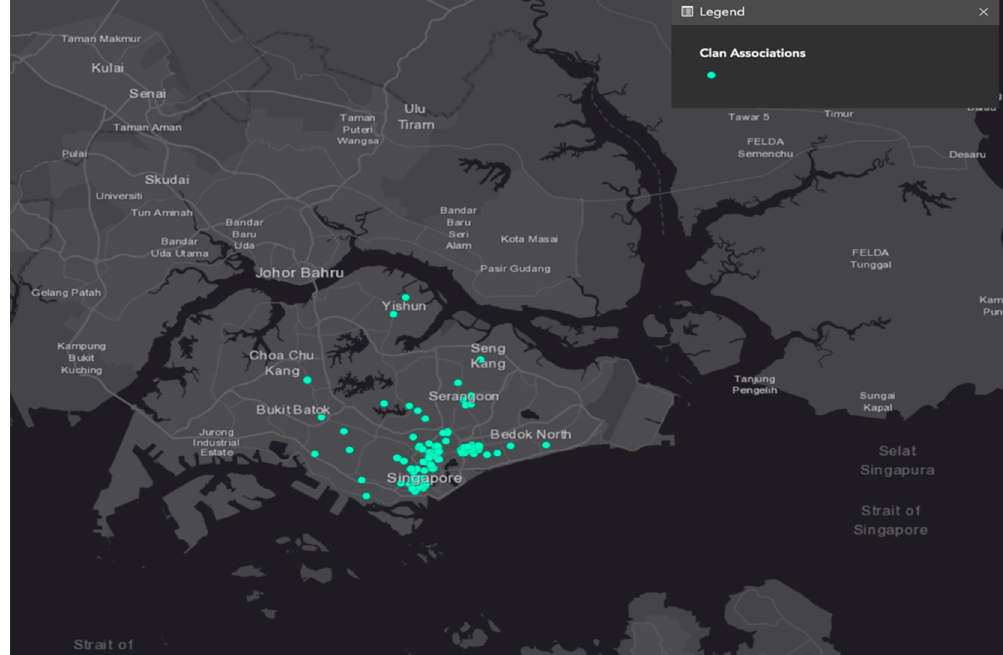
Figure 1. The Distribution of the Clan Organizations in Singapore (Singapore Historical GIS 2020).